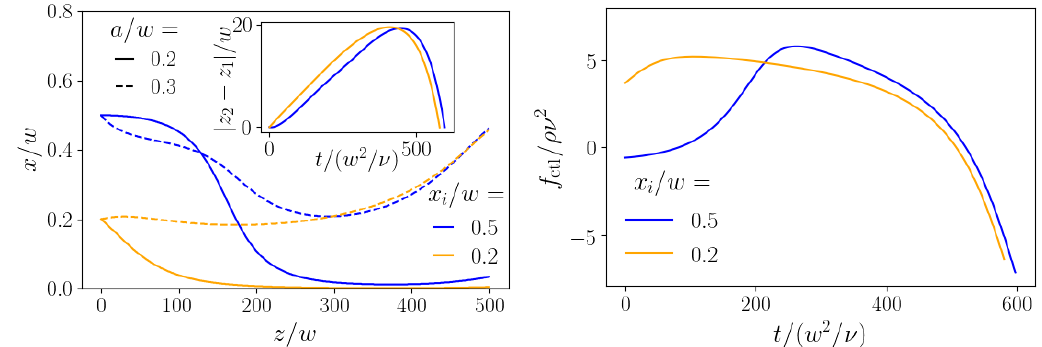
Figure 11. Maximizing the lateral distance of two particles with different radii a / w = 0.2 and 0.3 using ( t ) . The particles both enter at the same inlet at x the same control-force protocol f ∗ i and travel an axial ctl distance with optimal value z t = 500 w during time T ∗ . ( Left ): trajectories of the two particles for both initial conditions. Inset: axial separation over time of the two particles. ( Right ): optimal control-force protocols for the two initial lateral positions x i = 0.2 w and 0.5 w